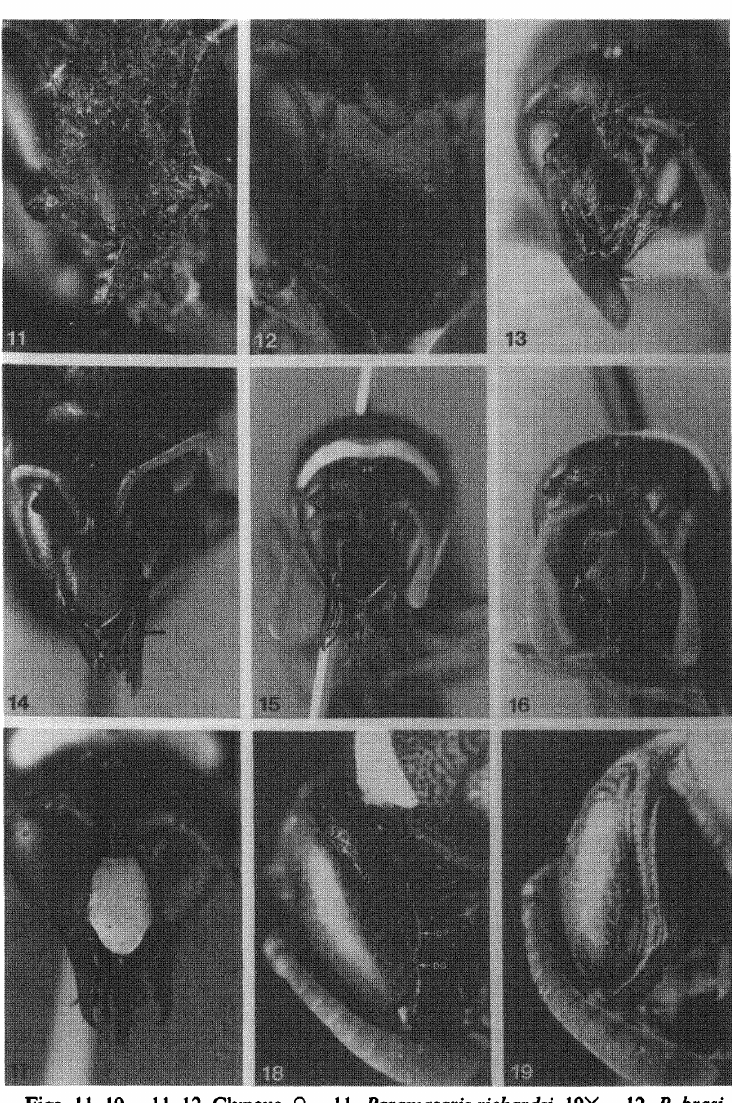
. . 11. Paramasaris richardsi, 19. 12. P. brasi- Figs. 11-19. 11-12. Clypeus, 13. P. cupreus, 14. 14. Gayella , liensis, 27X. 13-16. Frontal view of head, mutilloides, 5>(. 15. G. eumenoides, 7>( 16. G. araucana, 10. 17. G. reedi 10)<. Frontal view of head. 18-19. Lateral view of head. 18. G. araucana 15. 19. P. brasiliensis, 2IX. cc: apical clypeal carinae; g: gap between mandibular teeth; po: postocular carina; pr: preoccipital